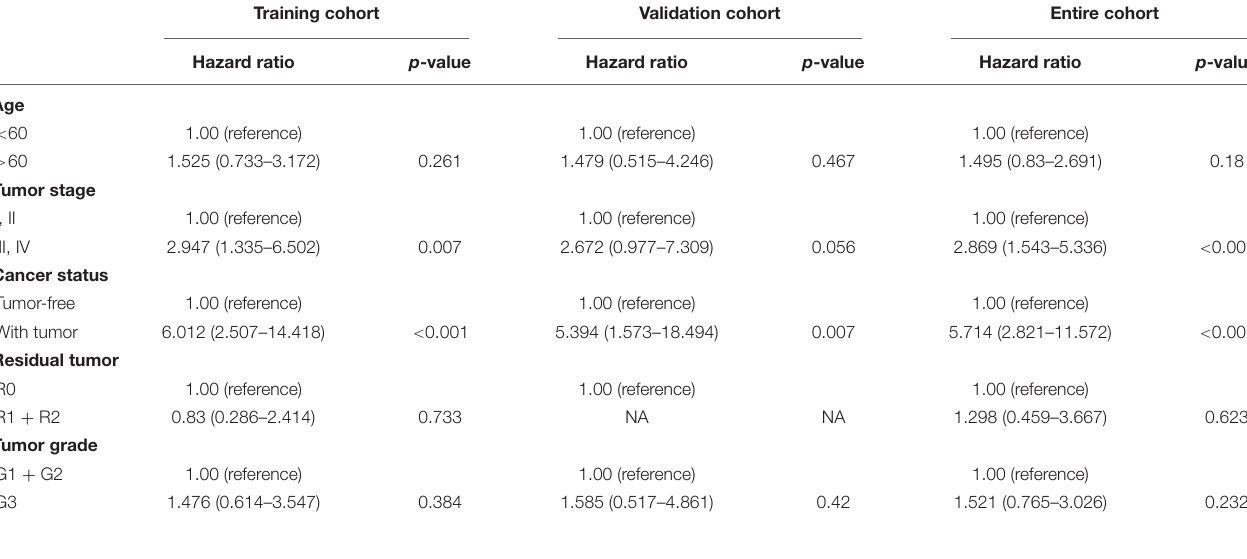
TABLE 2 | Multivariable Cox regression analysis of prognosis signature in different